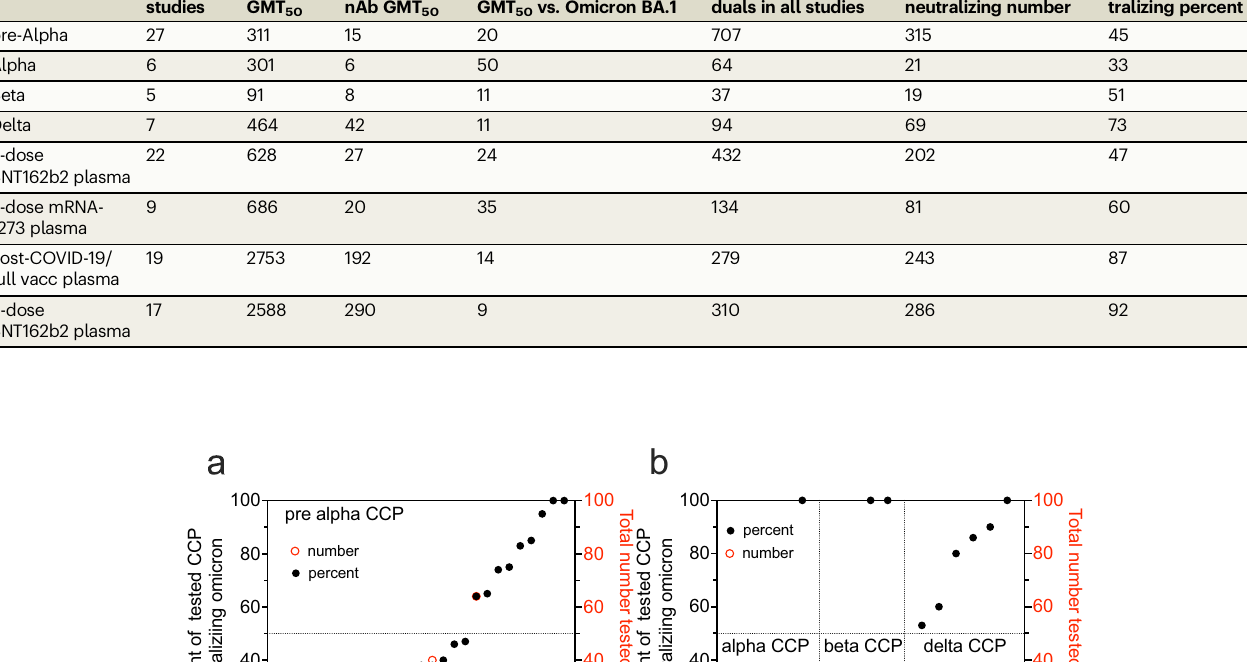
Table 1 | Comparison of WA-1 to Omicron BA.1 nAb and percent with any Omicron BA.1 nAb amongst VOC CCP and vaccination status Plasma type